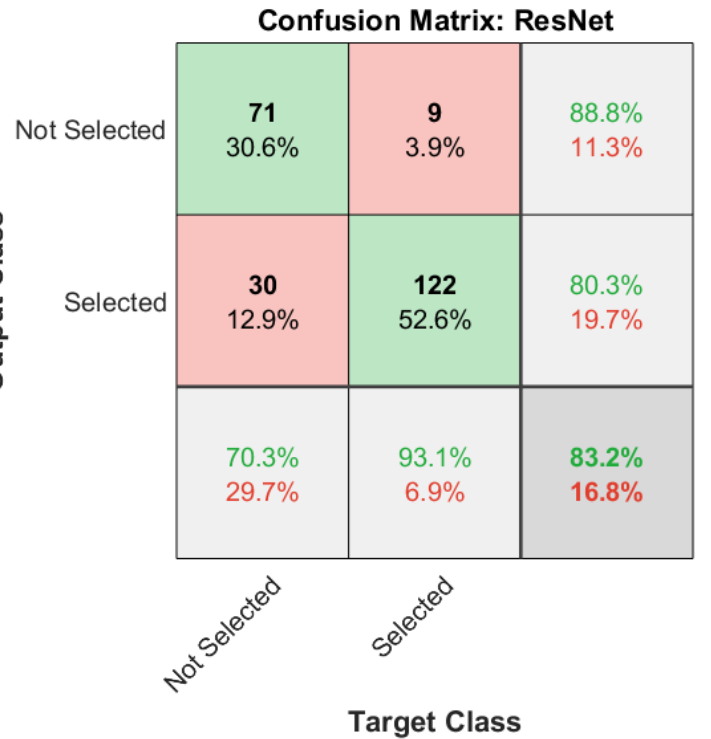
Figure 6. Testing performance of the selector network classifier as a confusion matrix. The diagonal cells represent the correctly predicted number of cases and the